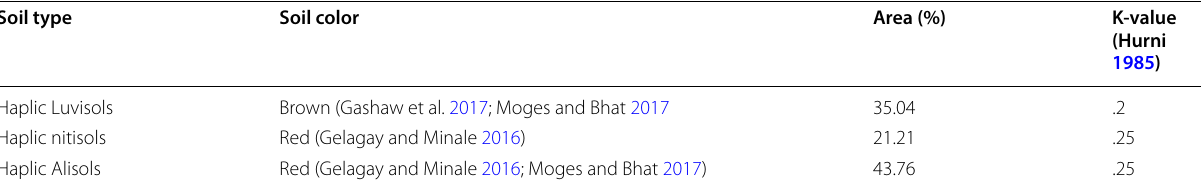
Table 3 Soil type, color and erodibility value of Gumara watershed Soil type